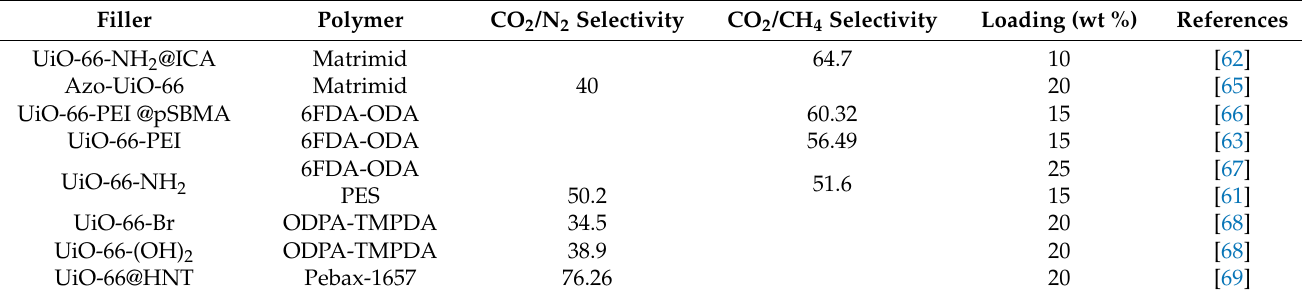
Table 3. Mixed-matrix membranes with UIO-66 in different